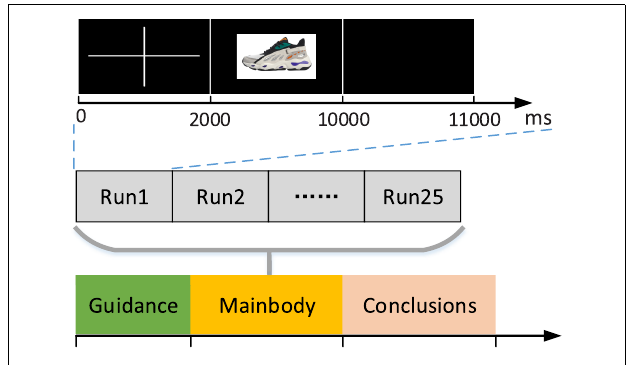
FIGURE 2 | The experimental protocol. The duration of each run was 11 s, a fixation cross was shown for 2 s, and then, a picture of specific shoe appeared for 8 s, followed by a rest of 1